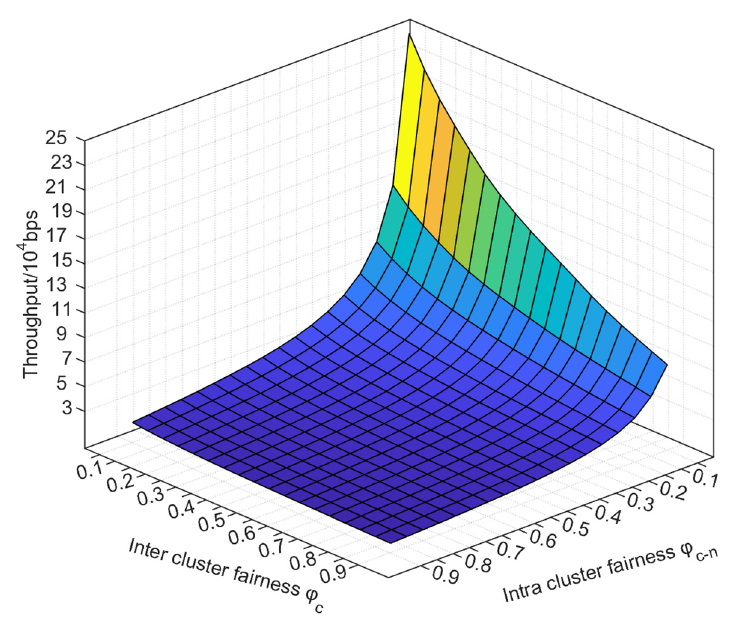
Figure 5. Throughput varies with intra and inter cluster fairness.